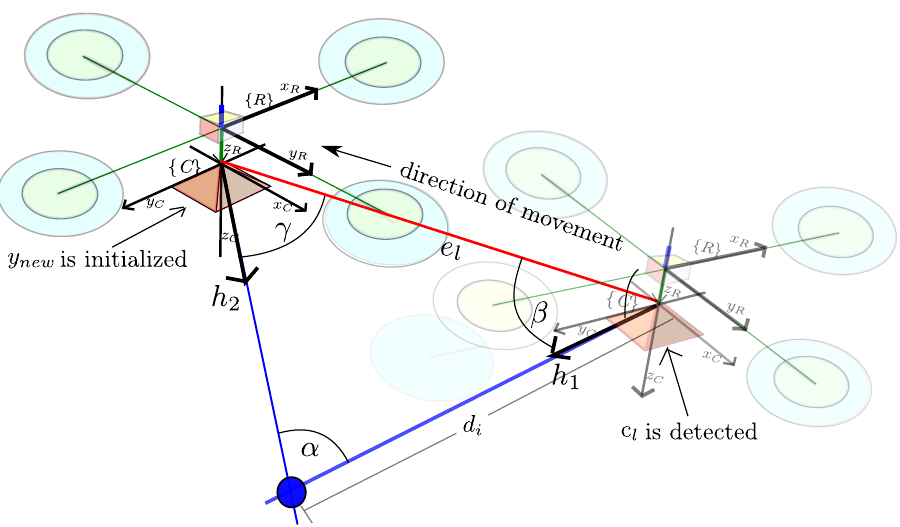
Figure 7. An hypothesis d i for the depth of a candidate point is computed by triangulating between the first location when the point was detected and the current location of the